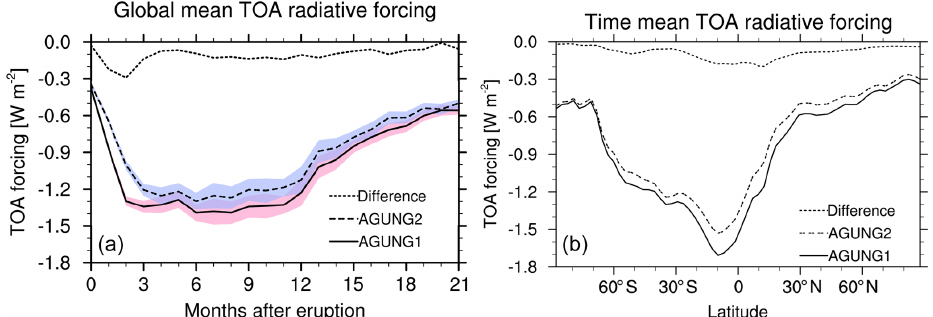
Figure 5. Top of the atmosphere (TOA) radiative forcing of sulfate aerosols under all-sky conditions. Aerosol forcing was calculated using a radiation double call. (a) Global mean TOA forcing over time. The shadings indicate the 2 σ variability range for both ensembles. (b) Zonally averaged radiative forcing as an average over time (21 months).